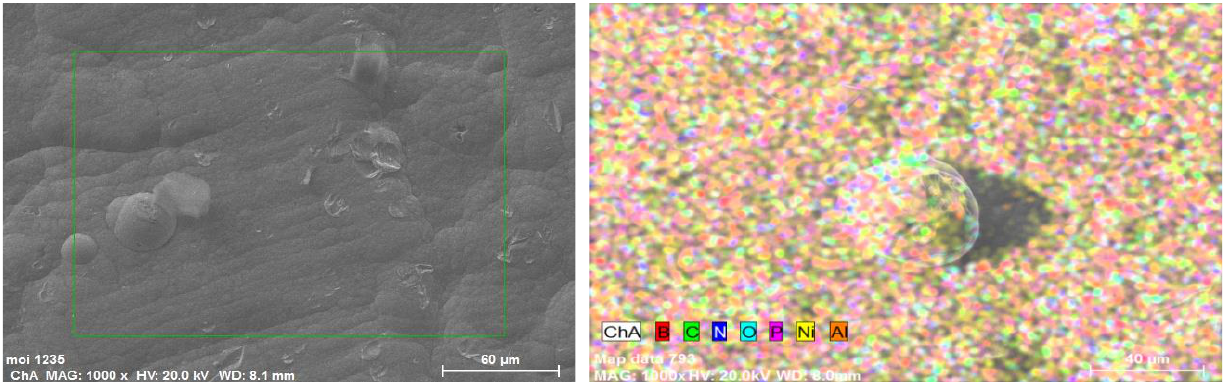
Figure 1. Surface morphology (SEM images) of as-deposited electroless Ni coating with embedded c-BN nanoparticles (Ni-BN) at different magnifications.